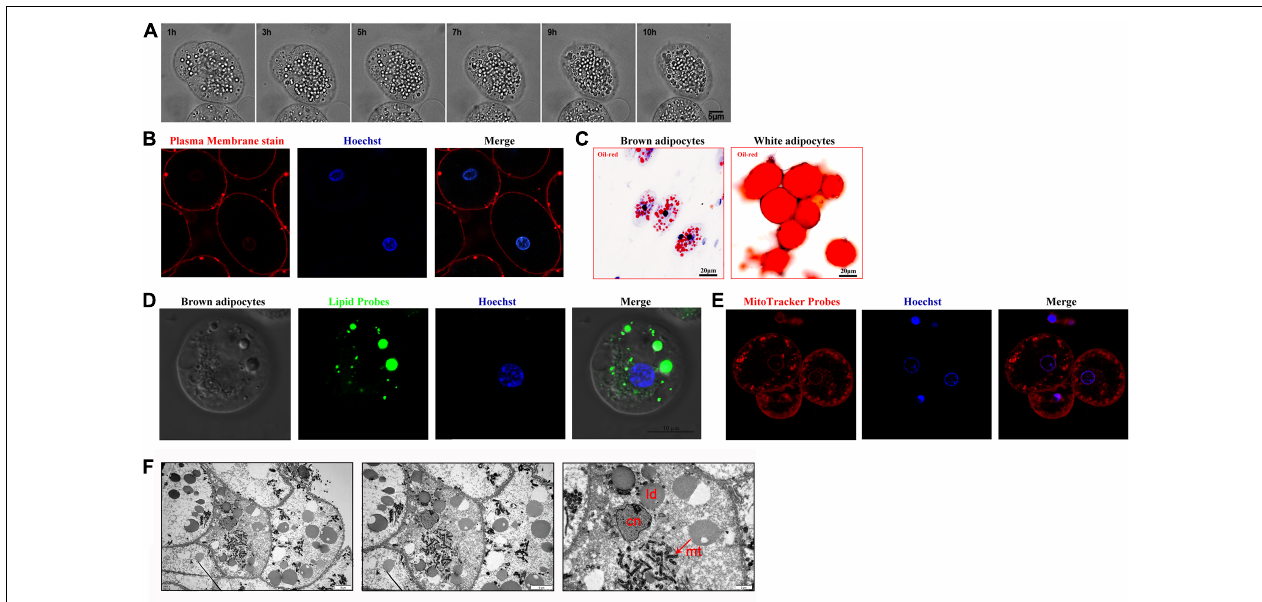
FIGURE 2 | Morphological characteristics of brown adipocytes surrounding the brain tissue of lampreys. (A) Time-lapse images of brown adipocytes were acquired every 10 min for 24 h. (B) The brown adipocytes were incubated in medium containing 0.5 µ g CellMask TM orange plasma membrane stain for 3 min and then stained with Hoechst. (C) Oil Red O was used to examine the morphology of brown adipocytes and white adipocytes. (D) Brown adipocytes were stained with lipid probes prior to staining with Hoechst. (E) The brown adipocytes were incubated in medium containing 30 nM MitoTracker Red. Merged images of cells double-stained with Hoechst are shown. (F) Mitochondria with dense cristae and larger lipid droplets in brown adipocytes under transmission electron microscopy (left pane). A higher magnification image is shown in the right